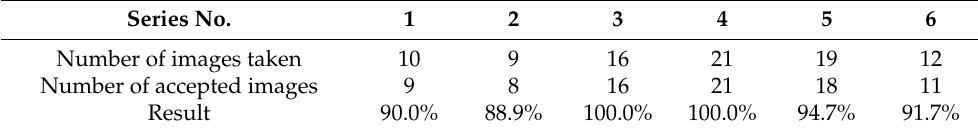
Table 10. The effectiveness of the algorithm responsible for detecting calibration targets. Series